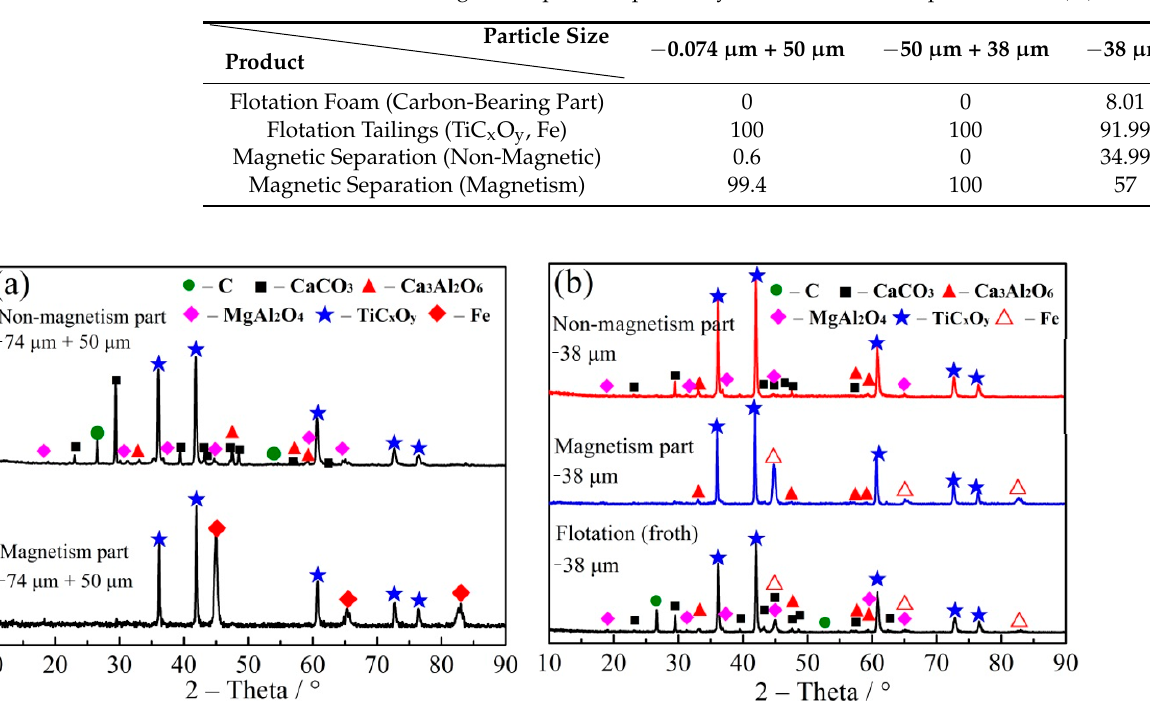
Figure 11. SEM-EDS of nonmagnetic part (EDS: atomic concentration).